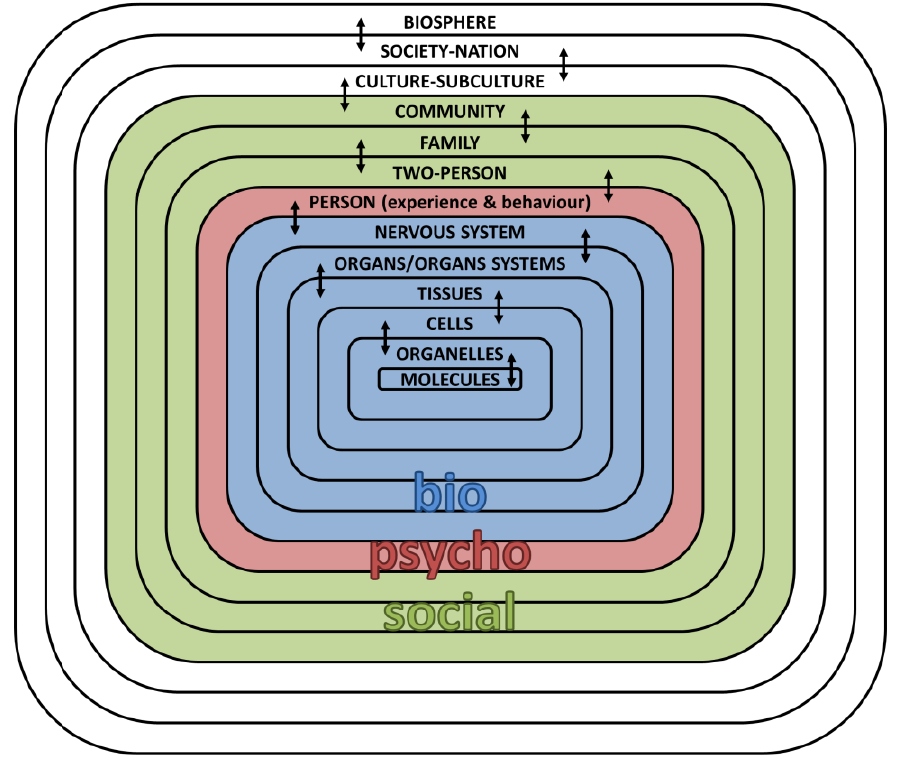
Figure 1. Schematic representation of the hierarchy and continuum of natural systems as applicable to Engel’s definition of the biopsychosocial model—adapted from ‘The clinical application of the biopsychosocial model’ [7].